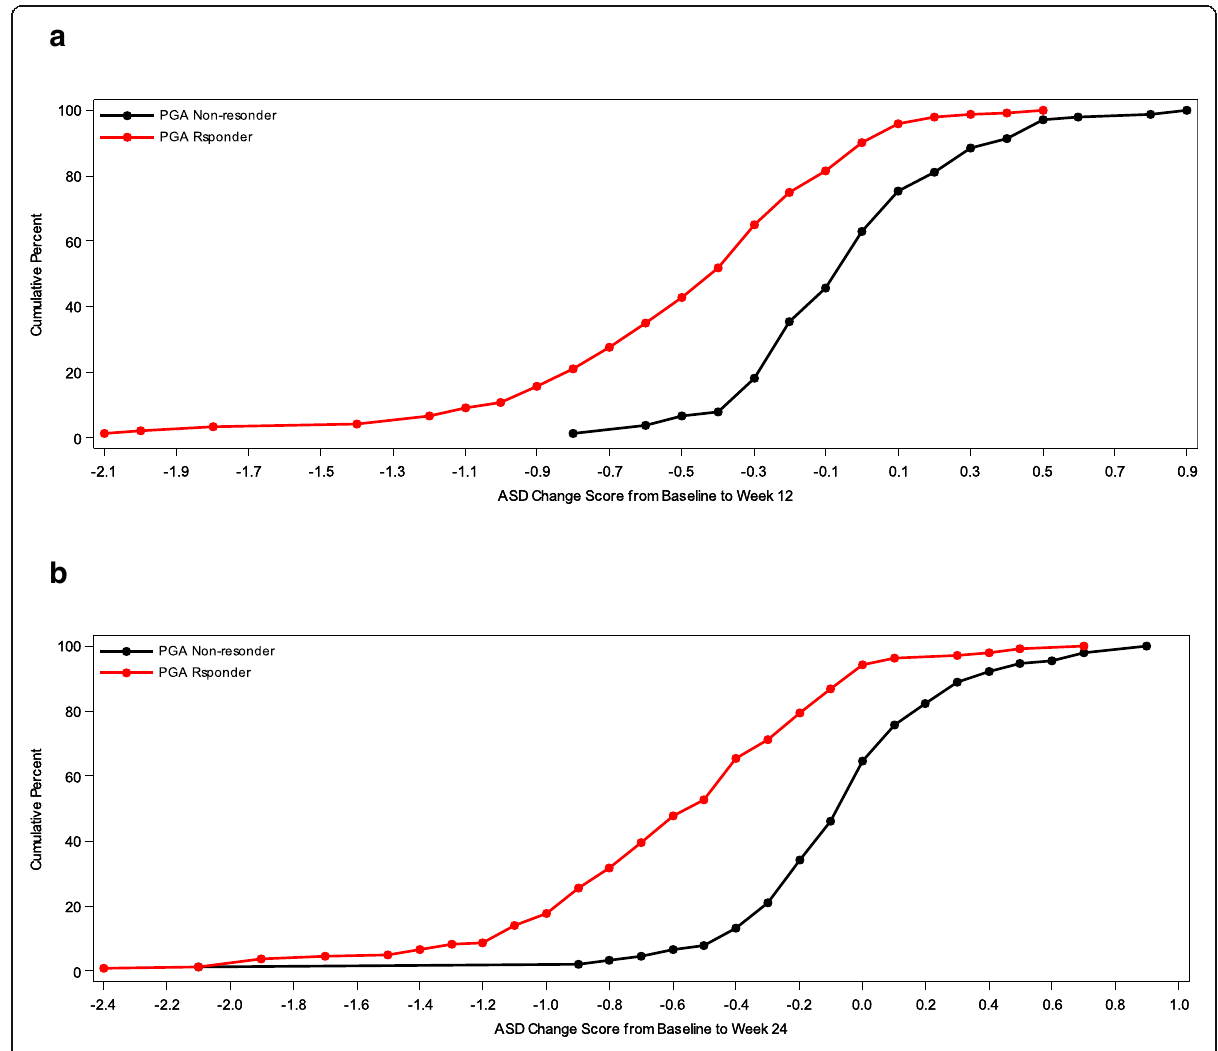
Fig. 2 Cumulative Distribution Curves for 7-Day Average ASD Scores by PGA Based Responder Criteria. a Baseline to Week 12 by PGA Response. b Baseline to Week 24 by PGA Response. PRO analysis set includes all subjects who are enrolled and have Asthma Symptom Diary measurement at baseline and at 12 weeks or